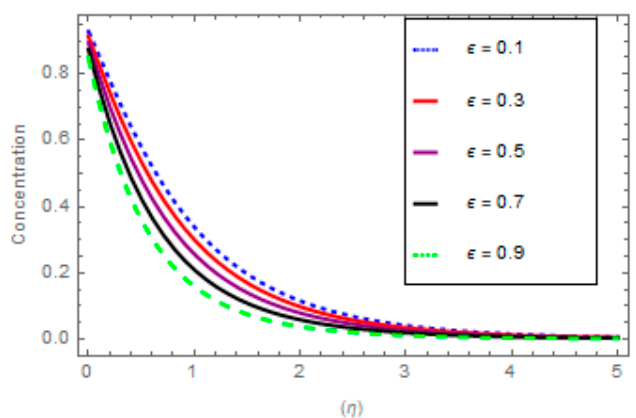
( ) ϕ η ( ) ϕ η ( ) ϕ η . S via . 2 .